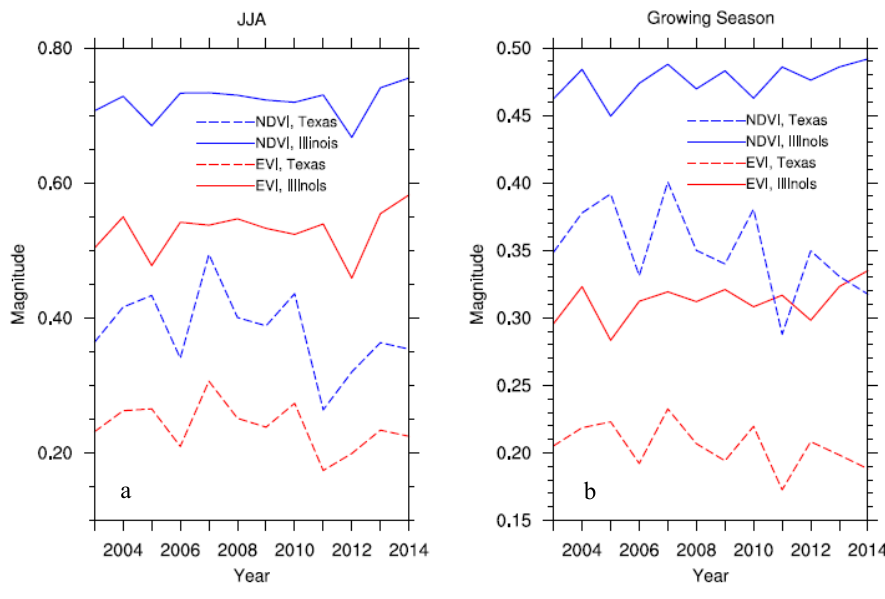
Figure 2. Interannual variations of regional mean NDVI and EVI for the period of 2003–2014 during ( a ) JJA and ( b ) the growing